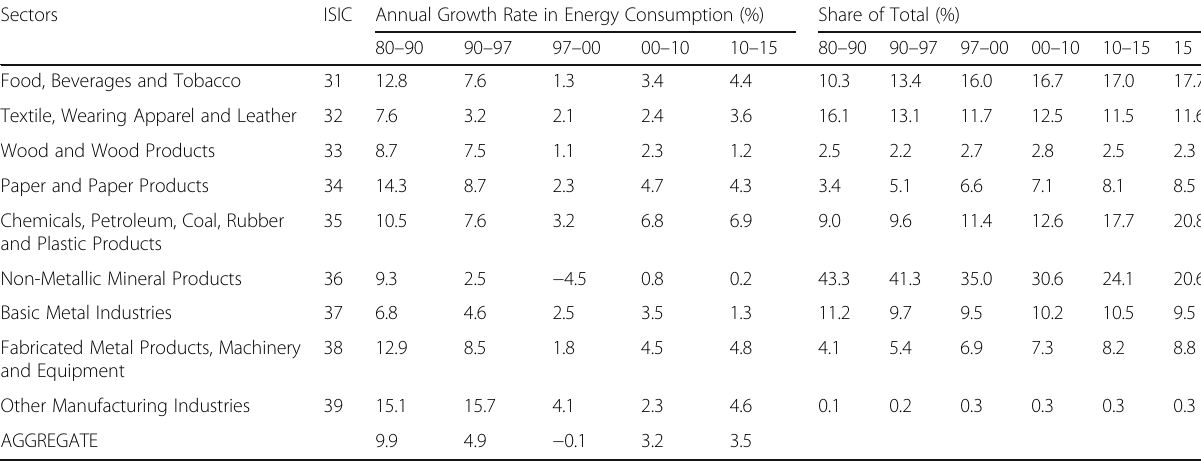
Other Manufacturing Industries (39) where each sector increased its energy consumption by more than 10%. In 1980, Non-metal Mineral Products (including cement and lime) was the largest energy user with total share reaching 43.3%, followed by textile around 16.1% and Basic Metal approximately 11.2%. During the financial crisis period of 1997 to 2000, the growth of energy consumption in several manufacturing subsectors decreased quite significantly. During this period, the aggregate energy consumption growth slo- wed to around − 0.1%, where Non-metal Minerals had the slowest growth compared to other sectors at around − 4.5%. However, after the financial crisis period from